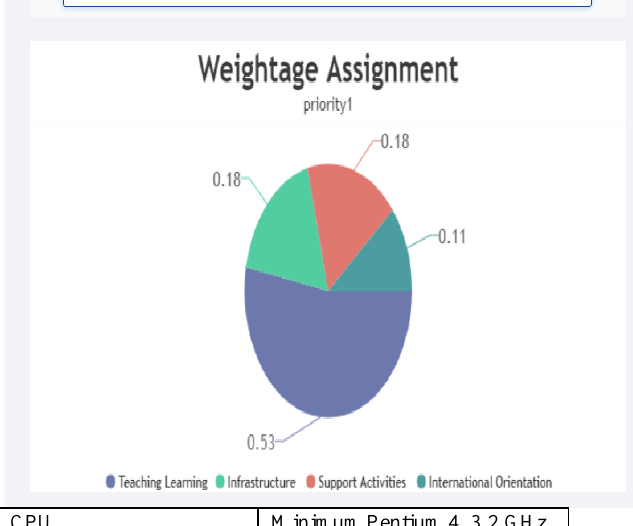
Table 4. Hardware requirements